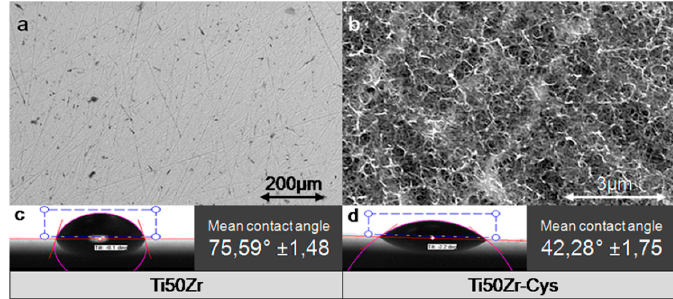
Figure 2. SEM images ( a , b ); and water contact angle images ( c , d ) ofTi50Zr substrate and Ti50Zr-cys sample.